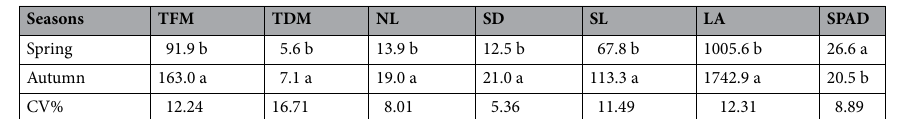
Table 2. Mean values of total fresh and dry matter (MPT and MDT in g), number of leaves (NL), stem diameter (SD in mm), stem length (SL in mm), leaf area (LA in cm 2 ) and leaf chlorophyll index (SPAD) of purple lettuce grown in different seasons of the year. Means followed by the same letter do not differ from each other at the 5% probability level (p < 0.05) by the Tukey test.